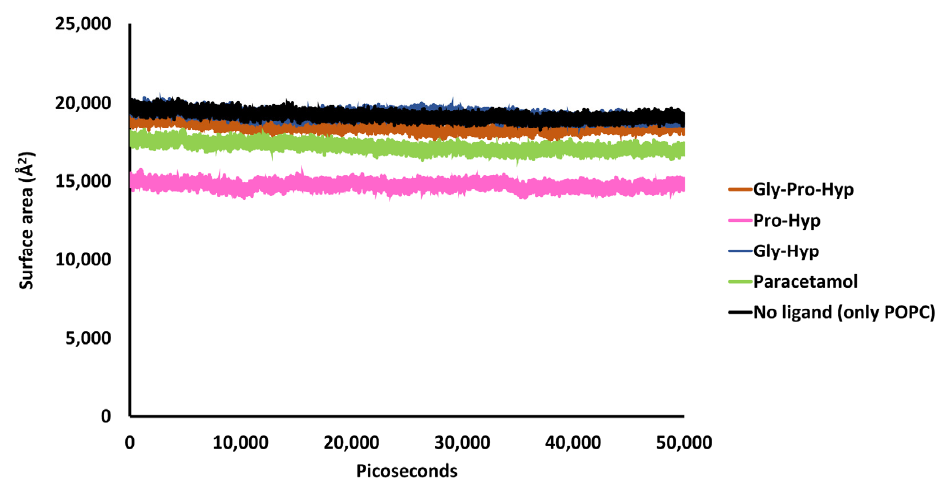
Figure 9. Time-series calculations of surface area (Å 2 ) of the phosphatidylcholine headgroup atoms in the upper and lower leaflets of Gly-Pro-Hyp ‒ POPC bilayer model (orange line), Pro-Hyp ‒ POPC bilayer model (pink line), Gly-Hyp ‒ POPC bilayer model (blue line), paracetamol ‒ POPC bilayer model (green line), and pure POPC bilayer model (black line) during the 50,000 ps simulations.